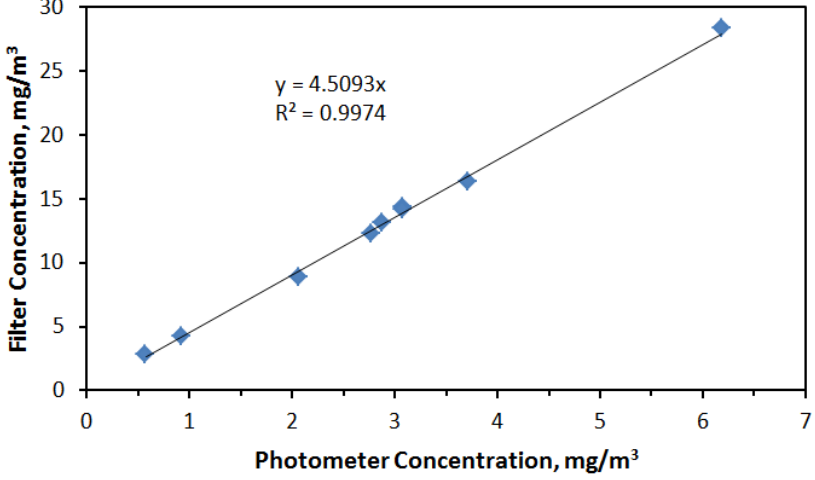
Figure 5. Linear relationship between photometer readings and associated aerosol concentrations measured